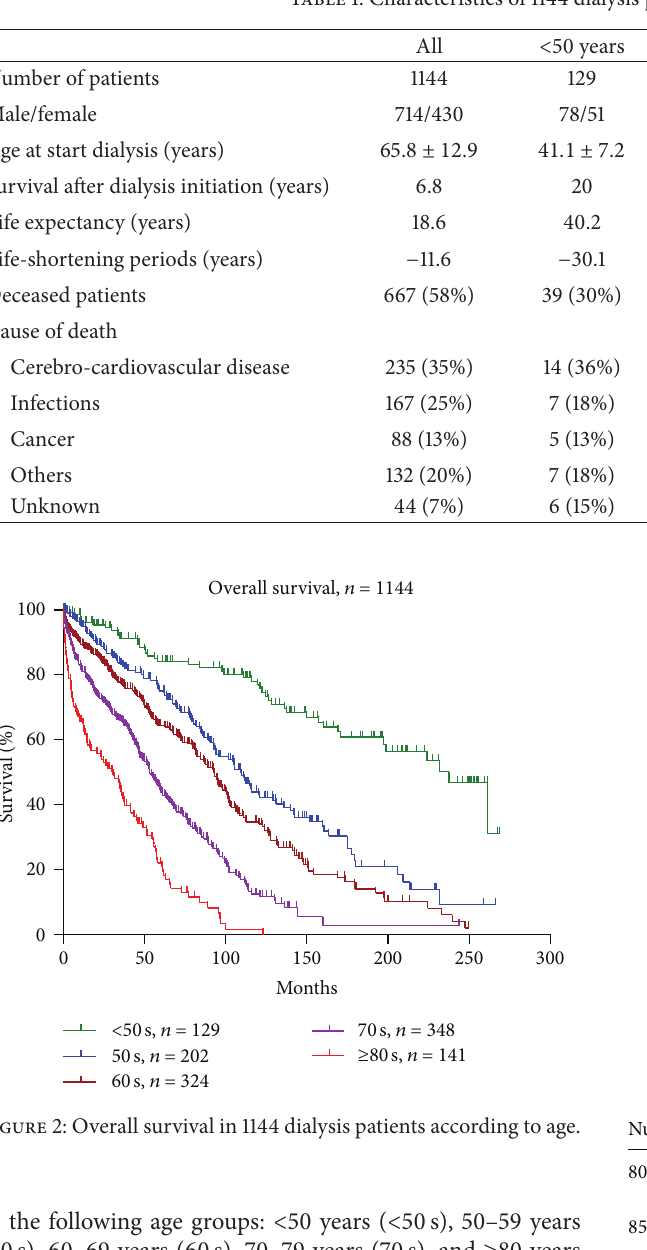
Table 1: Characteristics of 1144 dialysis patients included in this study.